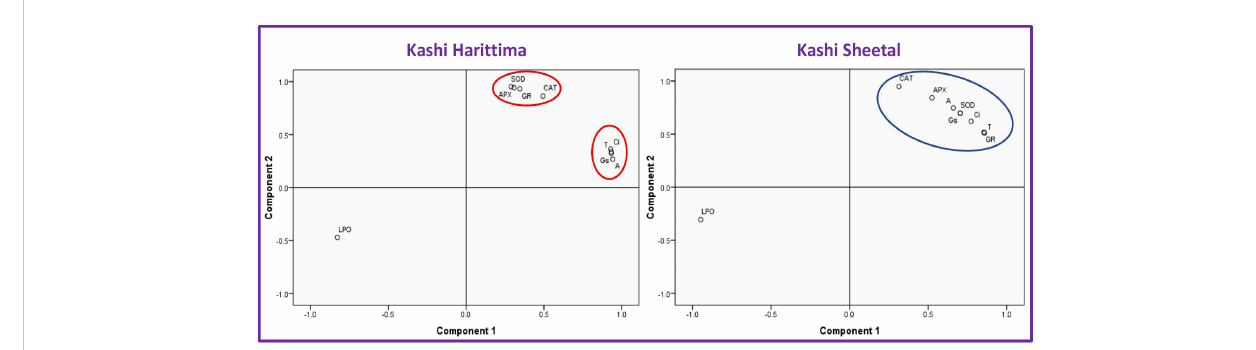
FIGURE 8 Principle Component Analysis (PCA) showed the association of considered parameters on two different components; i.e, component 1 and component 2. The parameters studied are APX, GR, SOD, CAT, LPO, Ci, g s, and (A) ( a ) Association of studied parameters in Kashi Harittima, (B) association of studied parameters in Kashi